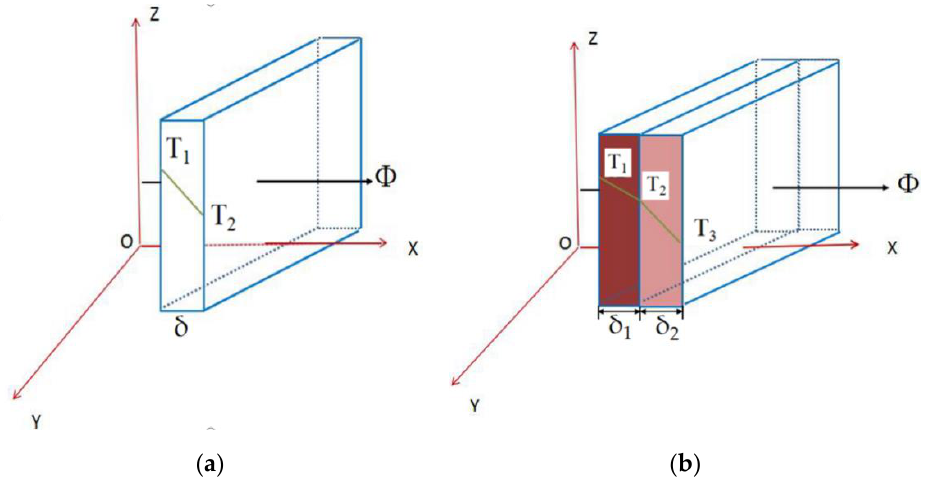
Figure 4. Schematic diagram of layer conduction of the plane wall. ( a ) Single-layer; ( b ) Multi-layer.